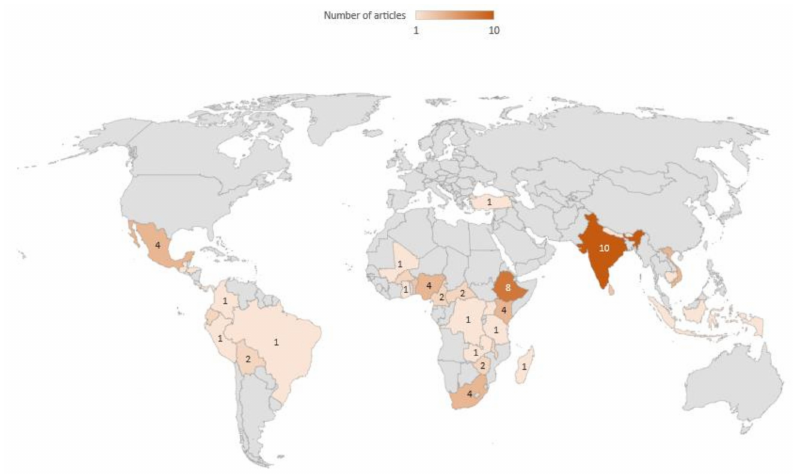
Figure 3. Location of study sites. (Copyright Australian Bureau of Statistics). (b) Whether study site was coastal or not (coastal = up to 10 km from coast or large lake) is shown in Figure 4.